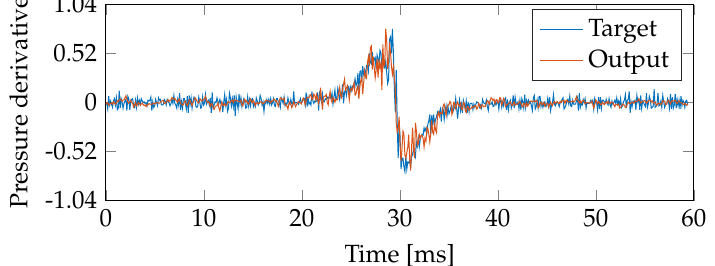
Figure 11. TDNN–based estimation of the pressure derivative (one record lasting 60 ms is shown as an illustrative example). Target and output pressure derivate prediction are shown for the following set-up: engine running at 1800 RPM with 0 BMEP load. The time delay is fixed as 100